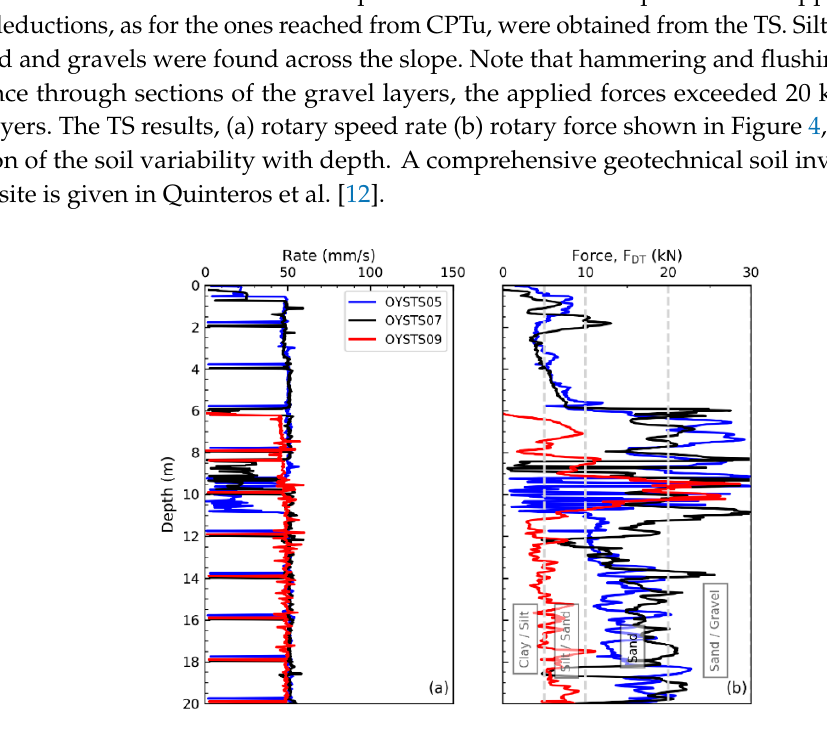
Figure 4. Location of most relevant field tests for slope stability screening analysis. ( a ) rotary speed rate with depth; ( b ) rotary force with depth.